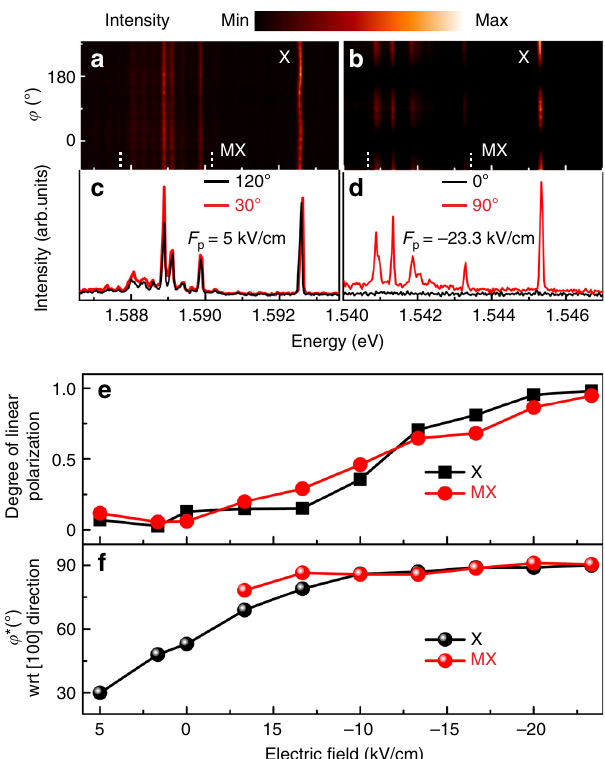
Fig. 3 Rotation of natural quantization axis under uniaxial stress along [100]. a – d Color-coded linear polarization-resolved PL spectra of a GaAs QD for increasing tensile stress ( a , b ) and selected spectra along orthogonal polarization directions ( c , d ). The polarization angle φ is referred to the [100] crystal direction. Initially, a , c the emission from the neutral exciton X and multiexcitons MX shows no signi fi cant net polarization and the X emission is characterized by two bright components linearly polarized along orthogonal but random directions (~30° and ~120° for this QD). This random orientation stems from slight anisotropy in the con fi nement potential de fi ned by the QD and also from some process-induced prestress. At large stress, b , d the PL is almost fully polarized along the [010] direction ( φ * = 90°). e Evolution of the degree of linear polarization of X emission and MX “ band ” (emission between vertical dashed lines in a and b for increasing tensile stress (increasing magnitude of applied electric fi eld on actuator). f Evolution of polarization orientation φ * for the MX band and for the high-energy component of the X line for varying stress (Fig. 3a, c) show no net polarization in the x – y plane, indicating weak HH z – LH z mixing 27,38,39 . The scenario changes completely under strong tension, as shown in Fig. 3b and d for the same QD: Light from X and MX becomes fully polarized parallel to the y - direction. This is exactly what we expect for a HH x -exciton, since the limited numerical aperture of the used objective (0.42) prevents us collecting z- polarized light. The degree of linear polarization, de fi ned as P = ( I max − I min )/( I max + I min ), with I( φ ) being the integrated intensity for the X or the MX lines, is shown in Fig. 3e. P increases with increasing stress and the angle φ * for which I ( φ * ) = I max aligns with the y -direction (perpendicular to the x quantization axis for the HH x state), see Fig. 3f. Because of low symmetry of the nanostructure and the strain-induced effects,